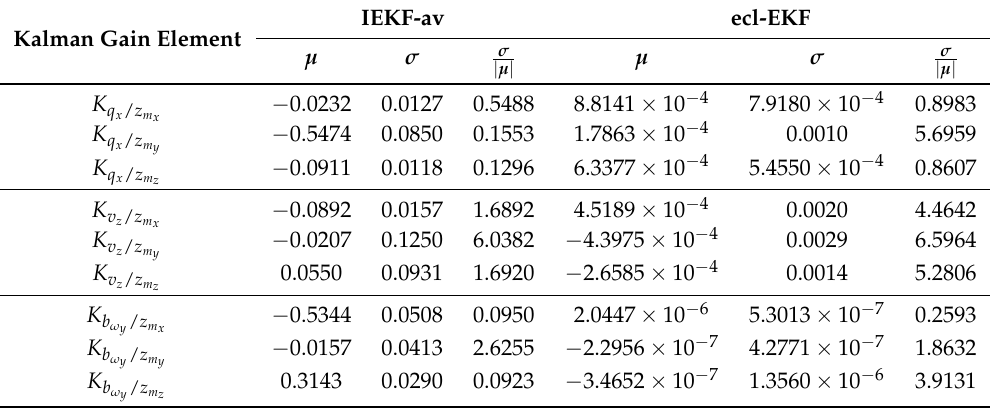
Figure 14. Comparison of Kalman gain for correction of x -component of quaternion relative to innovation of magnetic field measurements of IEKF-av and ecl-EKF. Table 7. Comparison of Kalman gain for estimation of attitude and velocity in quadrotor flight